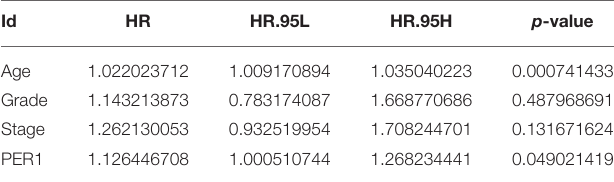
TABLE 2 | Multivariate COX regression analysis for